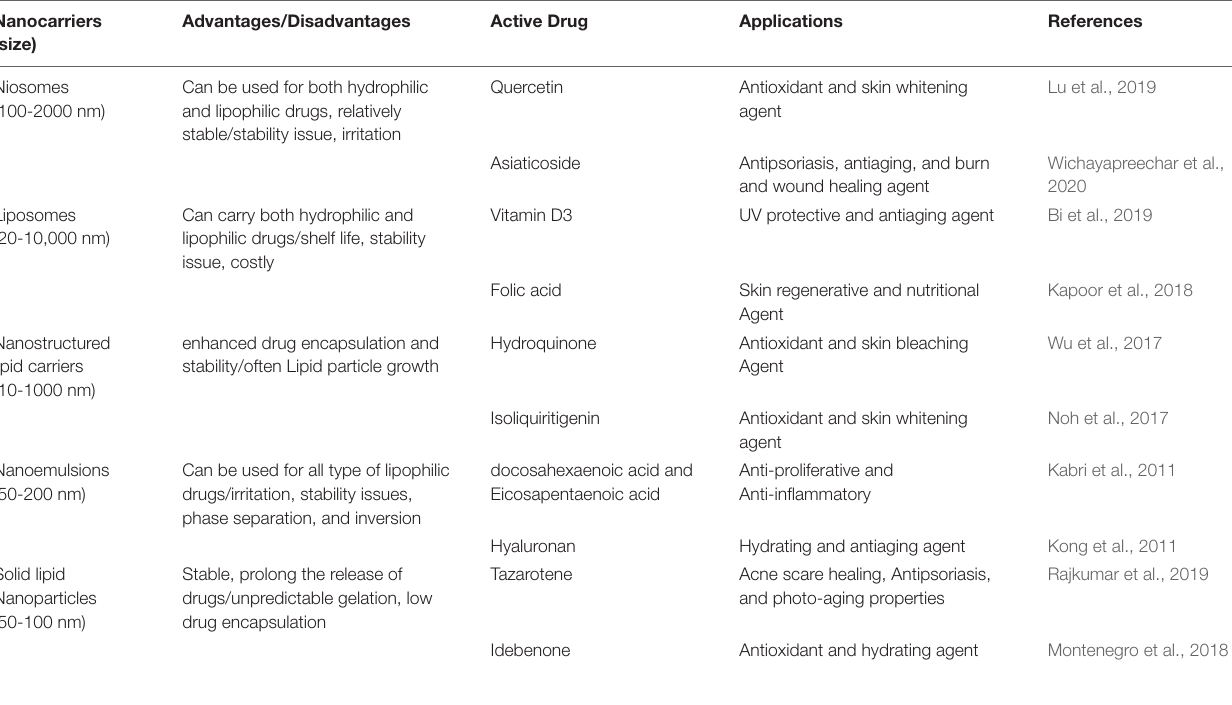
TABLE 3 | Examples of Nanocarriers combined with physical methods for transdermal drug